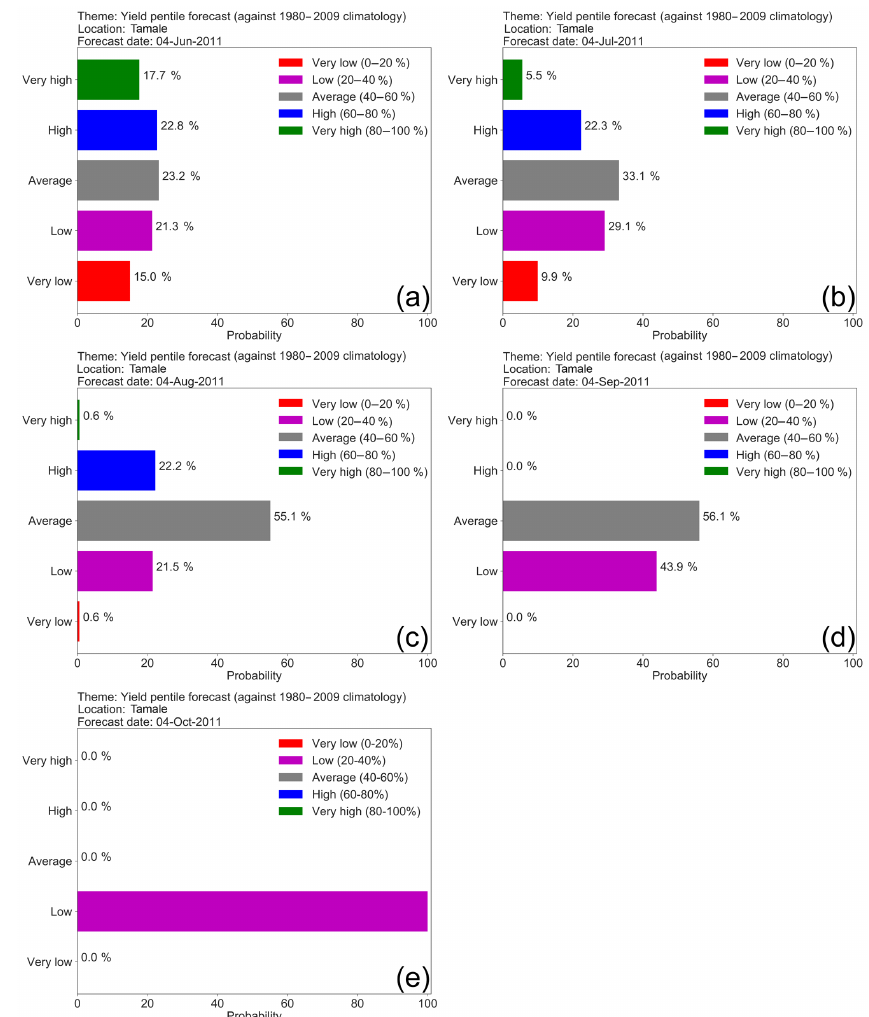
Figure 11. Probabilistic forecasts for maize yield in northern Ghana (Tamale) for five dates: (a) 4 June 2011, (b) 4 July 2011, (c) 4 Au- gust 2011, (d) 4 September 2011 and (e) 4 October 2011. The planting date was 4 June 2011. In the first day of planting the impact of the weather is not well indicated that the yield probabilities are spread more or less equally in all categories, but after 1 month on 4 July 2011 it is indicated that 62% of the ensembles fall in the average and low categories. After 2 months on 4 August 2011, 76% of the ensembles indicate an average and low yield estimate compare to the climatological yield. A few days before harvest on 5 September 2011, 100% of the yield is estimated to be in the average and low quintile